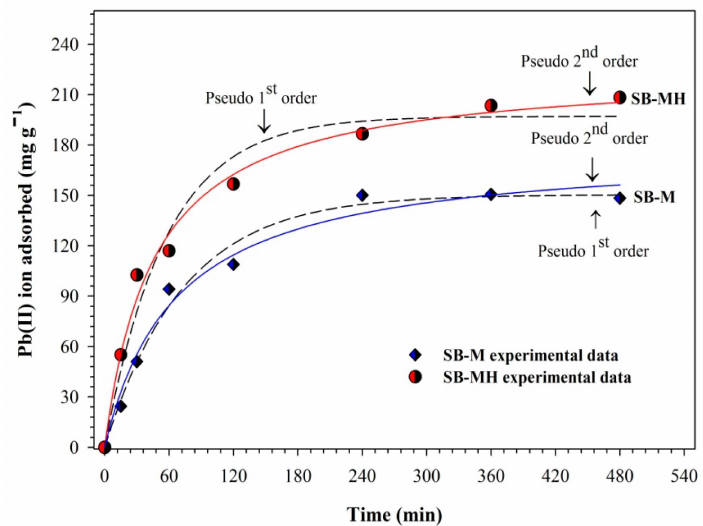
Figure 4. The kinetic profile of Pb(II) ion adsorption by SB-M and SB-MH at various contact times. Conditions: volume sample of 200 mL, pH 5, shaking rate of 150 rpm.